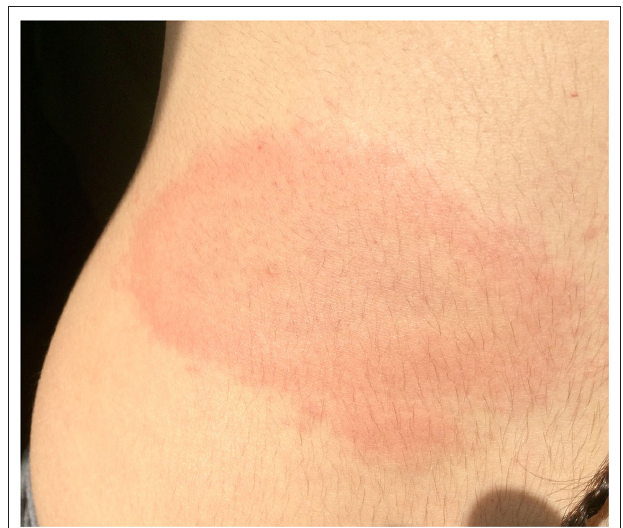
FIGURE 1 | Eythema migrans of the back developed in the first trimester of pregnancy (Case 7).